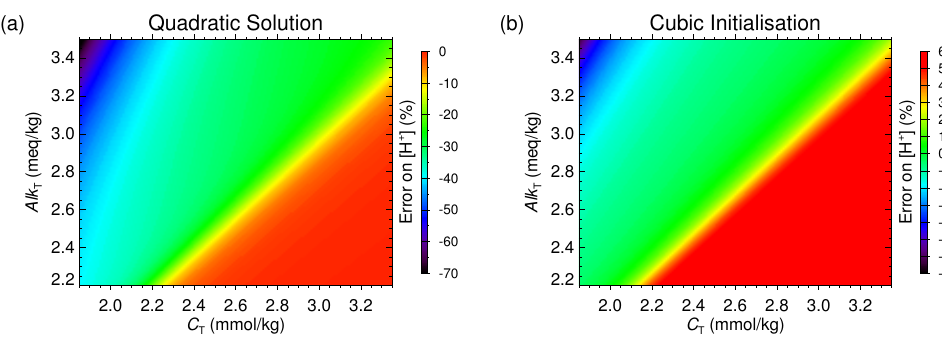
Fig. 4. (a) Relative deviation (in %) of the solution of the quadratic Eq. (8), calculated by setting Alk C = Alk T , from the actual root of the complete system; (b) idem for the cubic polynomial based initial [H + ], calculated by setting Alk CB = Alk T . Please notice the strongly different colour scales (underlying data come from test case